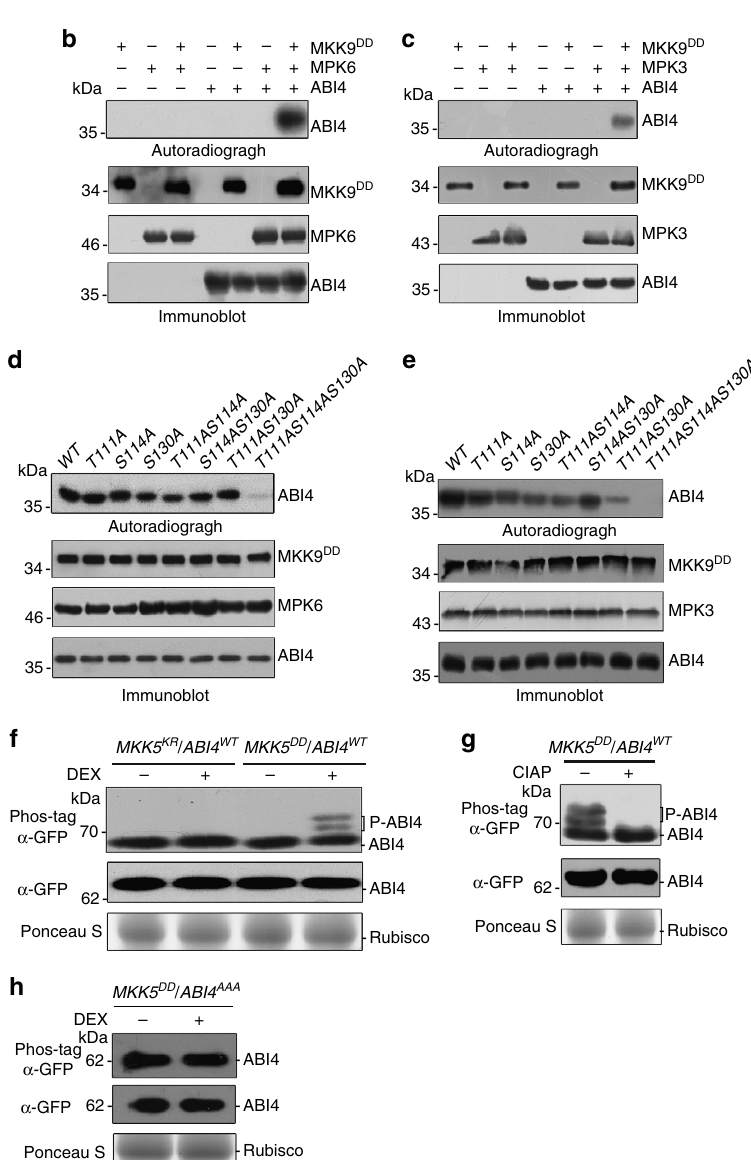
Figure 2 | Phosphorylation of ABI4 by MPK3 and MPK6. ( a ) Putative MAPK docking motif and three potential phosphorylation sites in the N terminus of ABI4. The MAPK docking motif is highlighted in red, and the potential phosphorylation sites are highlighted in green. ( b , c ) Phosphorylation of recombinant ABI4 by the activated MPK3 and MPK6 in vitro . Recombinant MPK3/MPK6 were first activated by MKK9 DD and subsequently incubated with ABI4 in